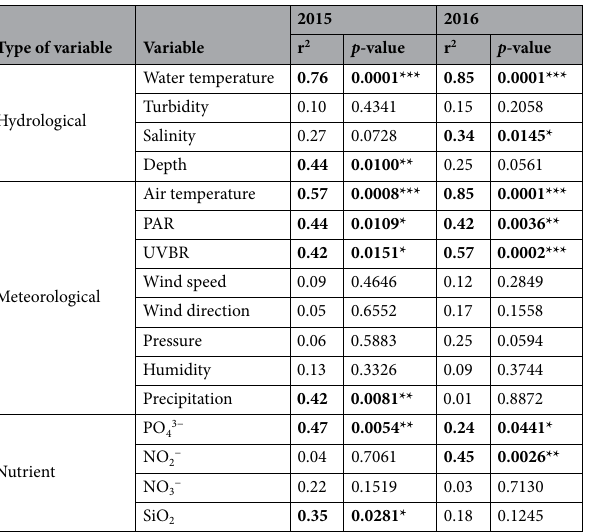
Table 1. Environmental parameters on nMDS axes. Bold values indicate significant correlations between environmental parameters and nMDS axes. Scores were calculated using a linear model including both axes. Asterisks represent significance levels: * represents p- value < 0.05; ** represents p- value < 0.01; and represents p- value <